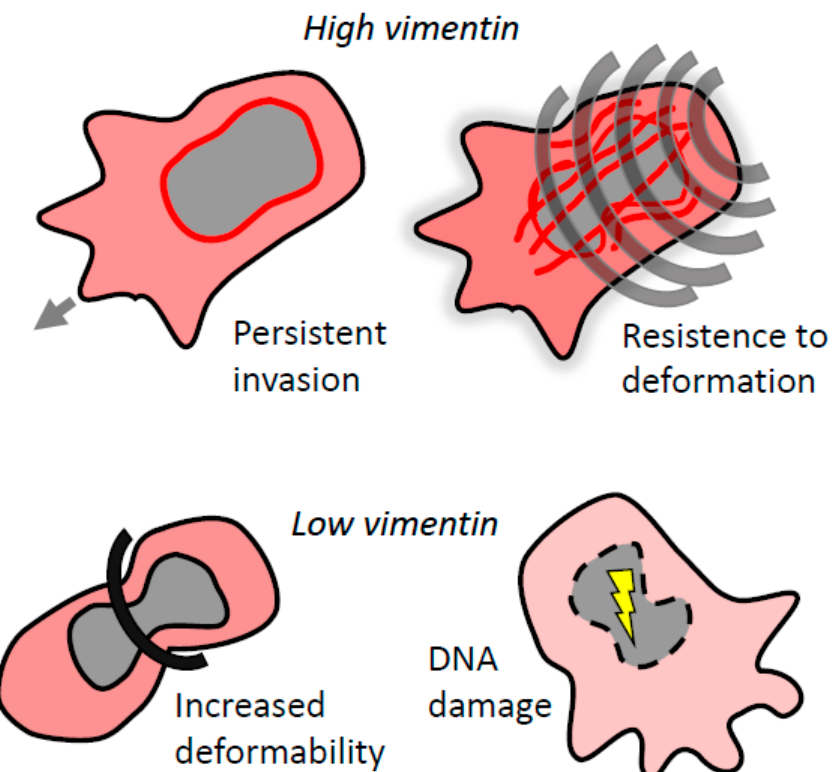
Figure 3. Vimentin regulates invasion in confined environments. Vimentin protects the nucleus from mechanical stress by controlling nuclear deformability. High levels of vimentin provide cells with enhanced resistance to deformation and lead to persistent migration. Low levels of vimentin result in loss of nuclear integrity and DNA damage, which abrogates invasion. However, in some cases, loss of vimentin can promote bleb-based